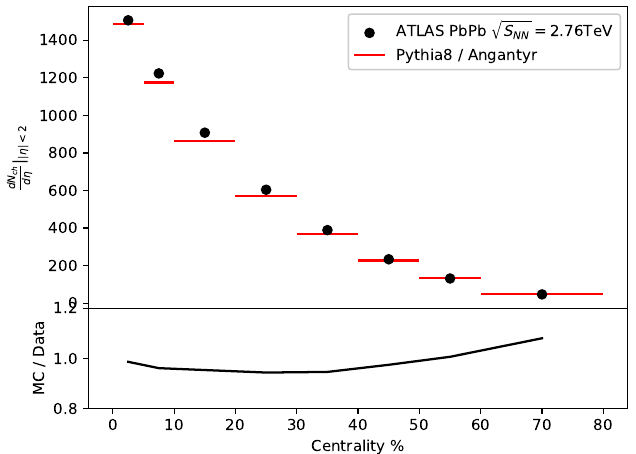
Figure 19 . Comparison to total multiplicity at mid-rapidity in PbPb collisions at p s 2 : 76 TeV, with a minimum p ? cut of 500 MeV, obtained by integrating the p ? distributions mea- sured by ATLAS